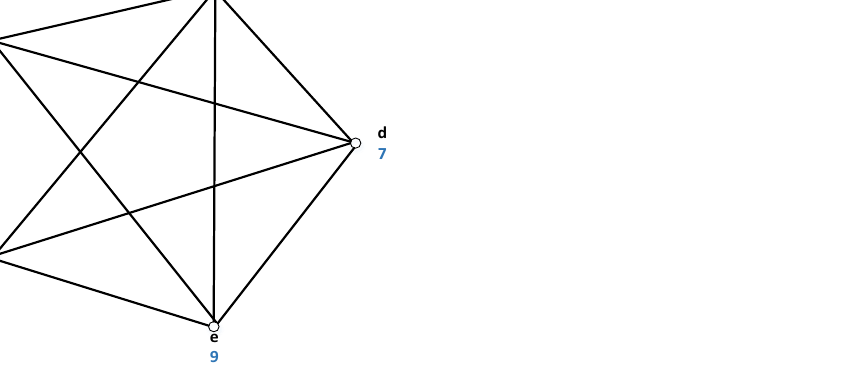
Figure 2. An unoriented complete graph with new potentials.